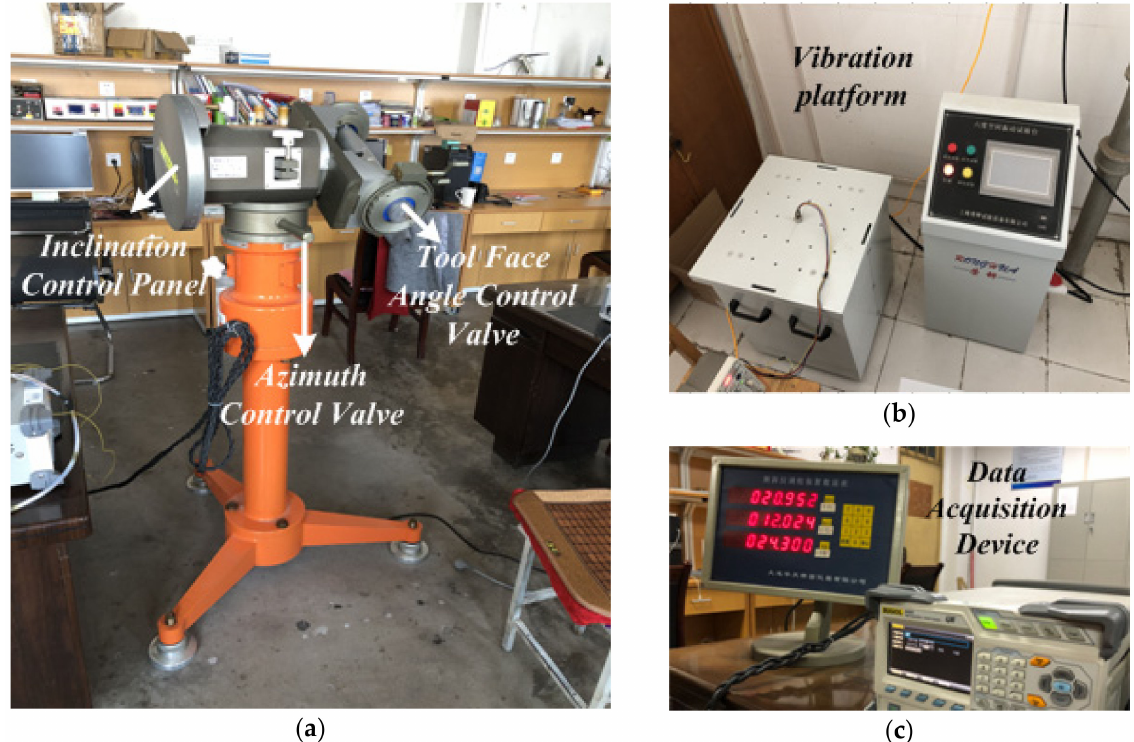
Figure 4. The main instruments and equipment in the laboratory: ( a ) an inclinometer adjusting device; ( b ) a six-degree space vibration experiment platform; ( c ) a data acquisition